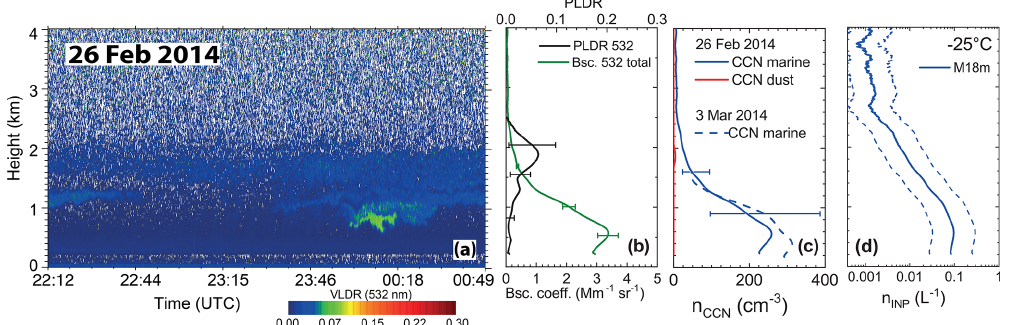
Figure 6. Pristine marine observation during the SALTRACE winter campaign on 26 February 2014, 22:12–00:49UTC. (a) Time–height display of the 532nm volume depolarization ratio, (b) particle backscatter coefficient (green line) and particle linear depolarization ratio (black line) at 532nm, (c) CCN number concentrations at water supersaturation of 0.2%, and (d) immersion-freezing INP concentrations at − 25 ◦ C for M18 marine. The dashed line indicates the uncertainty range (factor 3) of the INP